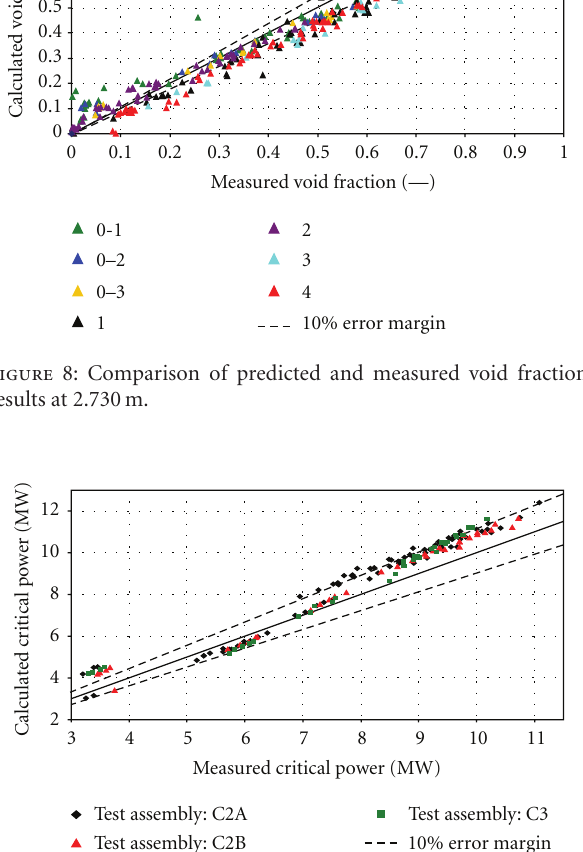
Figure 11: C / M ratio as function of bundle mass